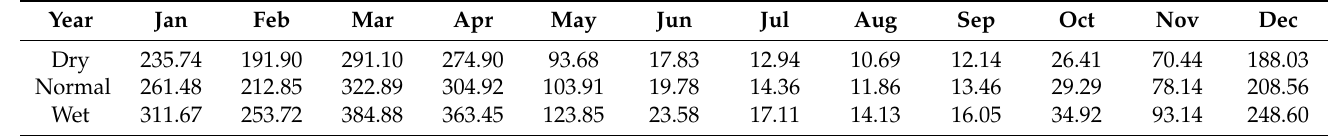
Figure 4. Monthly rainfall characteristics based on arithmetic mean between 1933–2019.